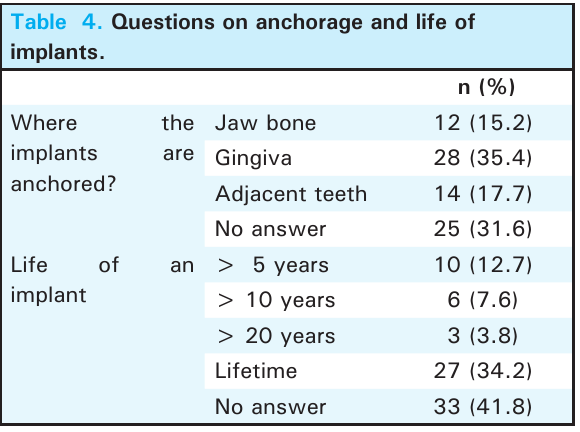
Table 4. Questions on anchorage and life of implants.